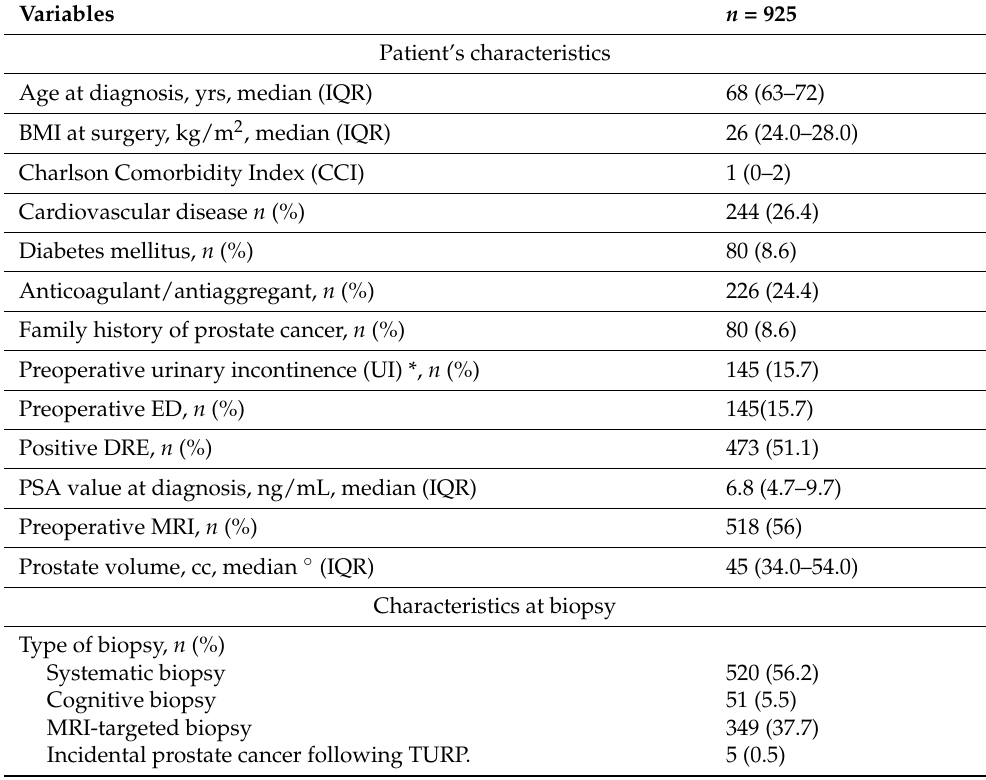
Table 1. Baseline patient and tumor characteristics in the overall